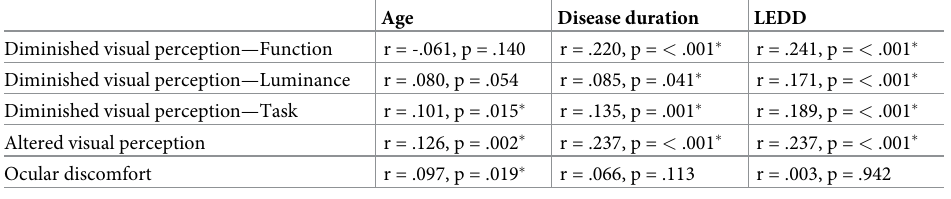
Table 10. Spearman’s correlations between subscale scores and age or disease